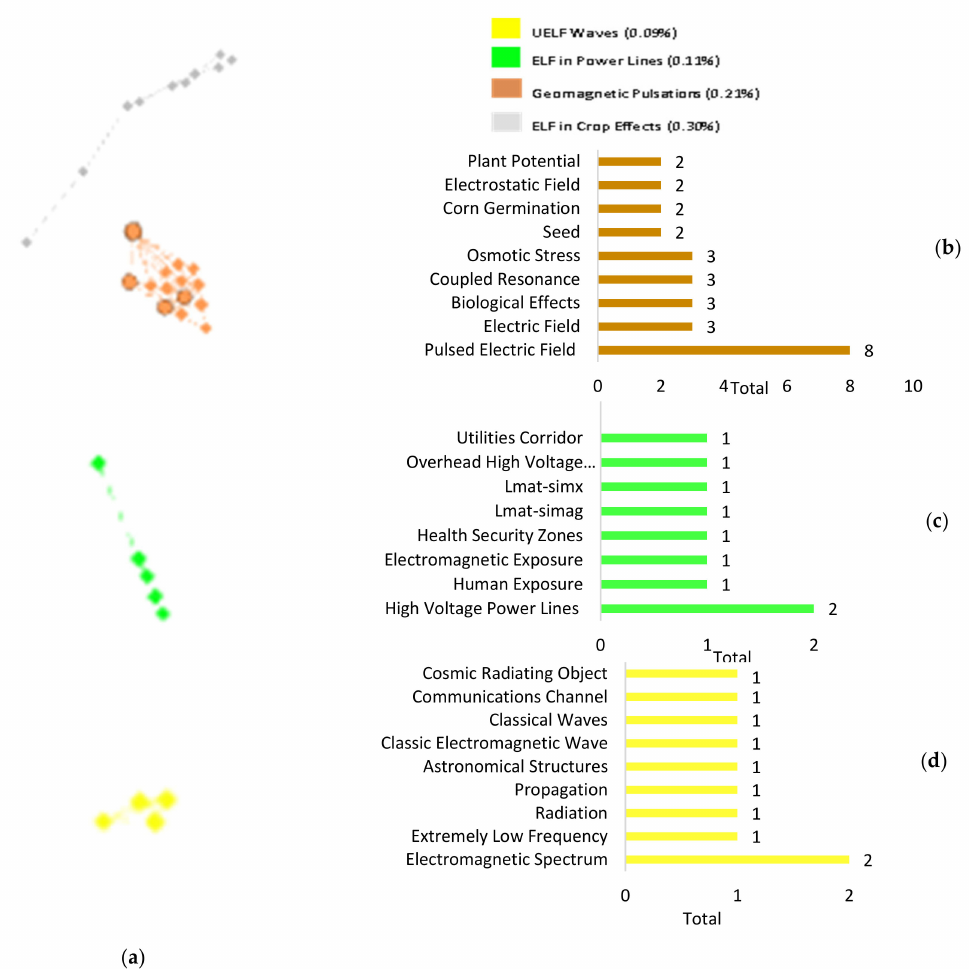
Figure 12. Representation of other communities: ( a ) isolated distribution of publications, ( b ) keywords of ELF in crop e ff ects community, ( c ) keywords of ELF in power lines community, ( d ) keywords of under extremely low frequency (UELF) waves